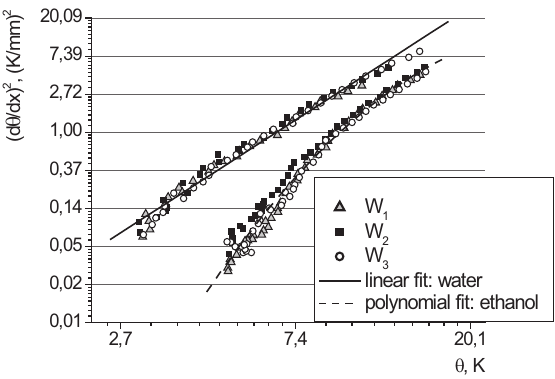
Fig. 3. Superheat gradient vs. superheat for three power levels (W) supplied to the heater; data for distilled water and ethanol The fitting procedure (either linear or polynomial) enables to obtain the constants, which are necessary to draw boiling curves (Eqs 1 and 4). They could be presen- ted in the form of dependency of heat transfer coefficient or heat flux, as presented in figure 4. Therefore, the res- ults obtained for the meshed surface can be compared with the data for the smooth surface, taken from (Or- man, Orzechowski